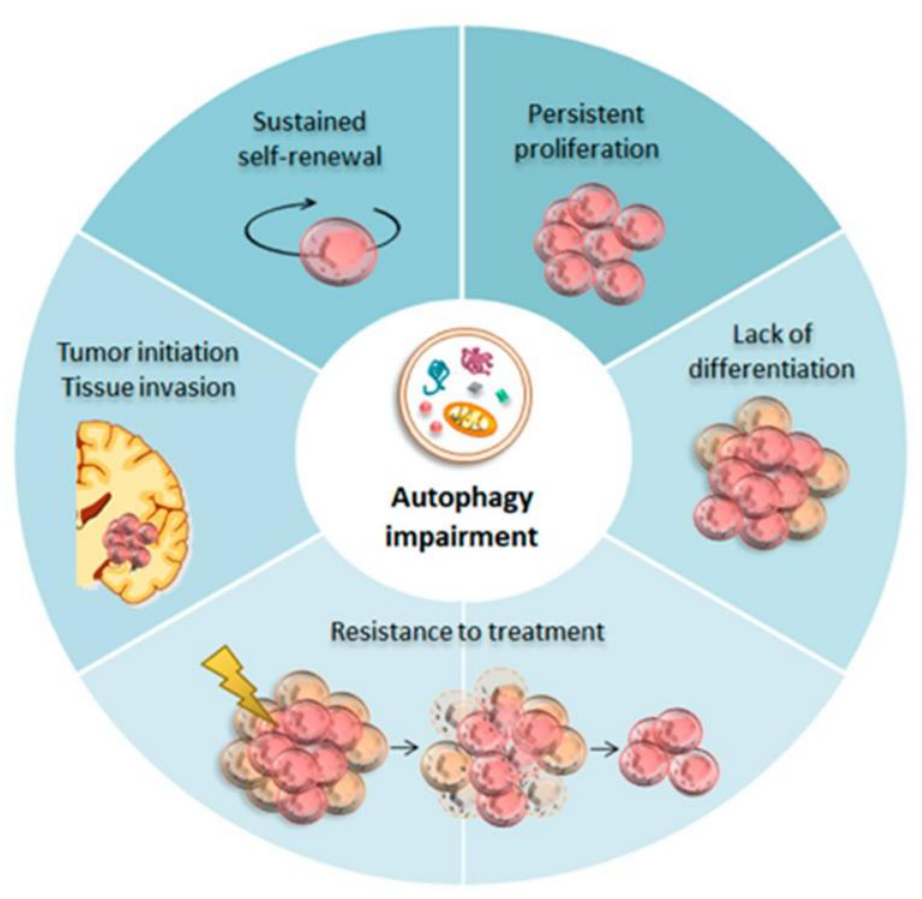
Figure 1. Autophagy in Glioma Stem Cells (GSCs). Baseline autophagy guarantees neuronal differen- Figure 1. Image copyrighted and re-drawn from our previous publication [51] — autophagy in Gli- oma Stem Cells (GSCs). Baseline autophagy guarantees neuronal differentiation and homeostasis tiation and homeostasis within the neural stem cells (NSCs) niche during development. Impaired within the neural stem cells (NSCs) niche during development. Impaired autophagy seems to be autophagy seems to be crucial for GSCs tumor crucial for GSCs tumor initiation [51].